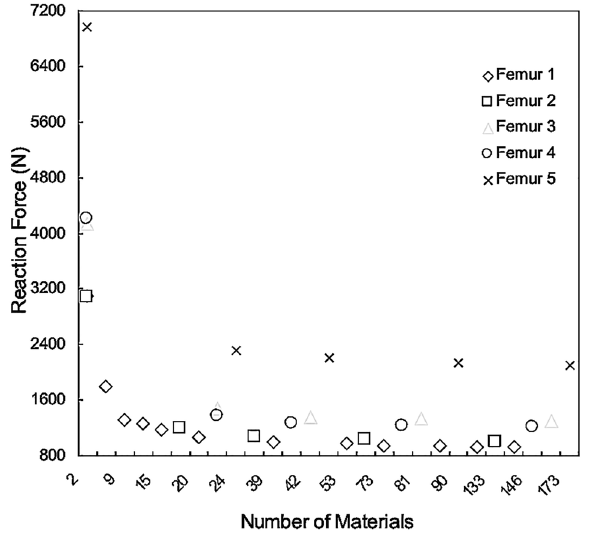
Fig. 12 Effect the number of material definitions has on computa- tional results